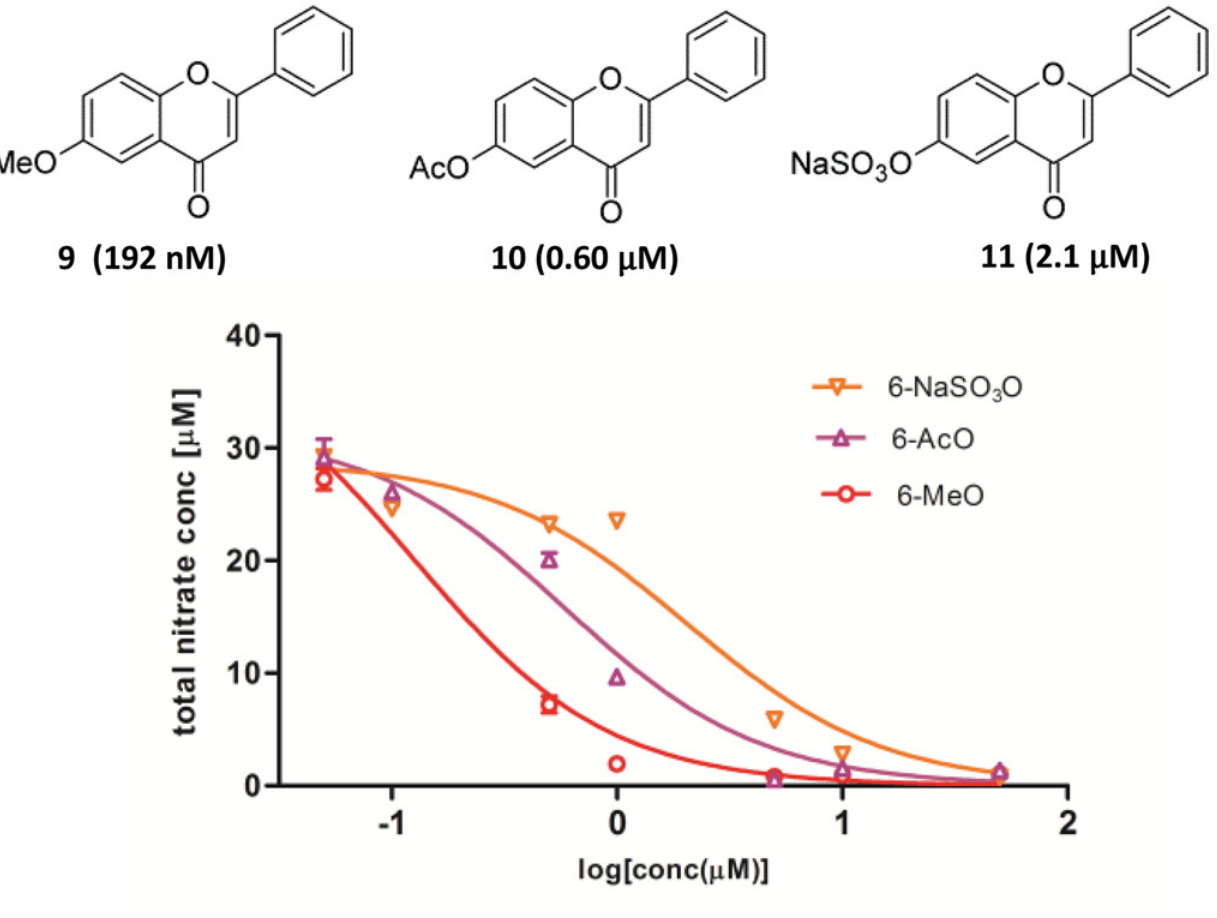
Fig 4. The inhibition of LPS-induced NO production in kidney mesangial cells by 6-methoxyflavone, 6-acetoxyflavone and flavone 6-sulfate. The total production of nitrite in the treatment media was measured with Griess assay at 48 h post 10 ng/mL LPS stimulation. IC 50 values were obtained using the dose-response analysis provided by the Graphpad Prism software as shown in